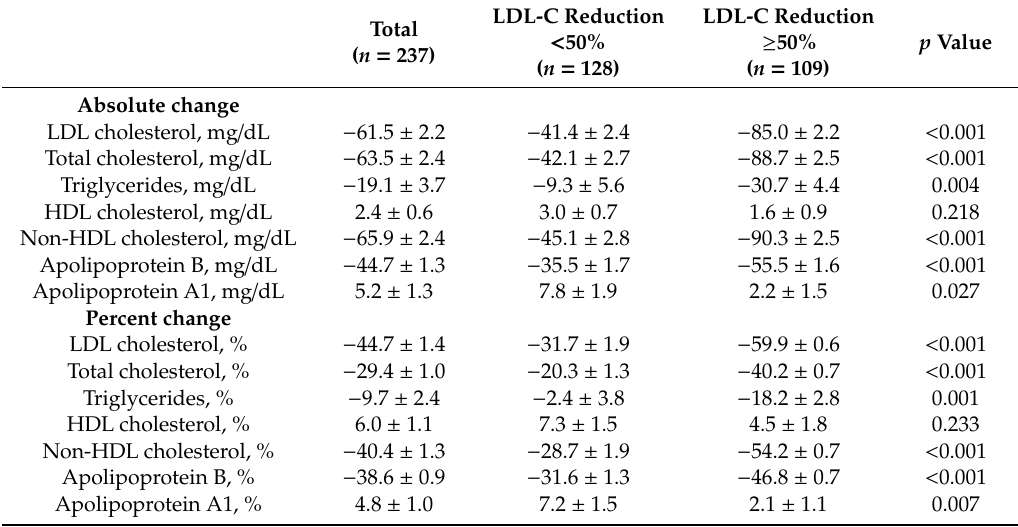
Table 4. Changes in lipid profiles of subjects who reached 50% LDL cholesterol reduction versus